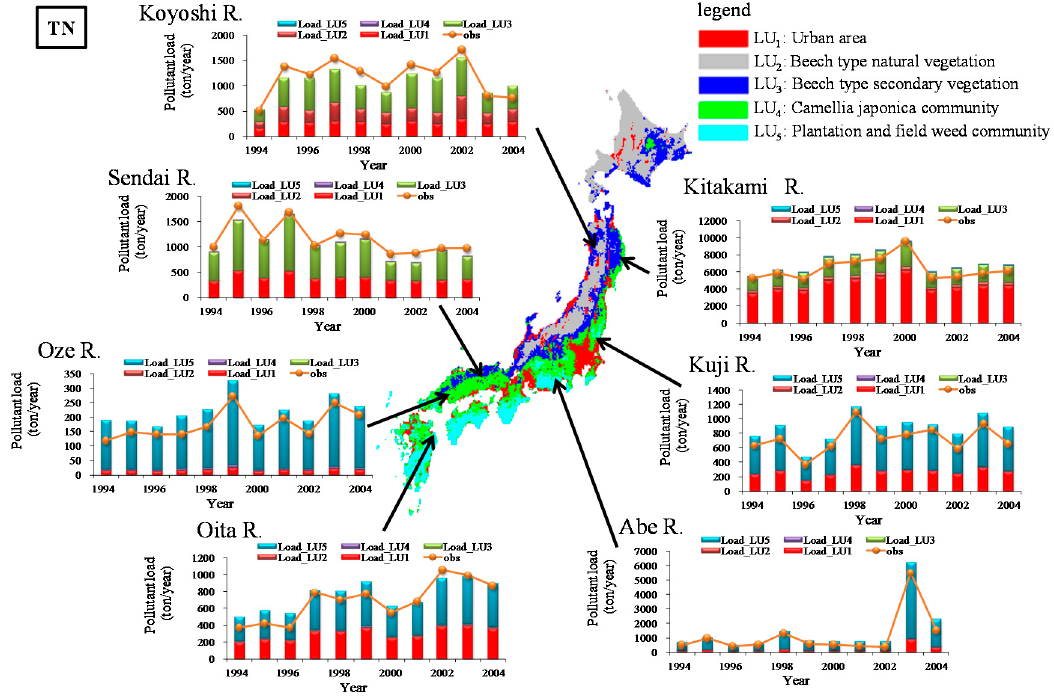
Figure 6. Total nitrogen (TN) loads associated with different land covers in 30 Japanese catchments from 1994 to 2004.